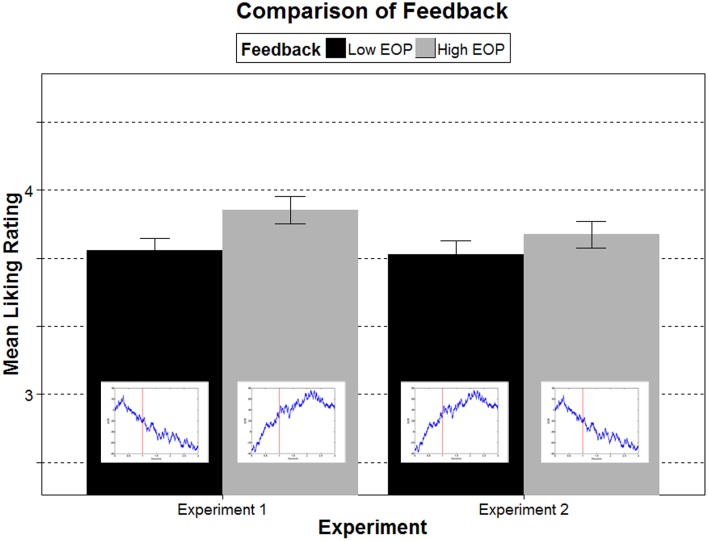
The effects of false feedback show that in both experiments mean liking was higher following a feedback of high ease of processing compared to low ease of processing. This effect did not depend on the mapping between the SCR curve and the ease of processing. Liking was increased regardless of whether an increase (left side, Experiment 1) or a decrease (right side, Experiment 2) in the SCR curve indicated a high ease of processing.